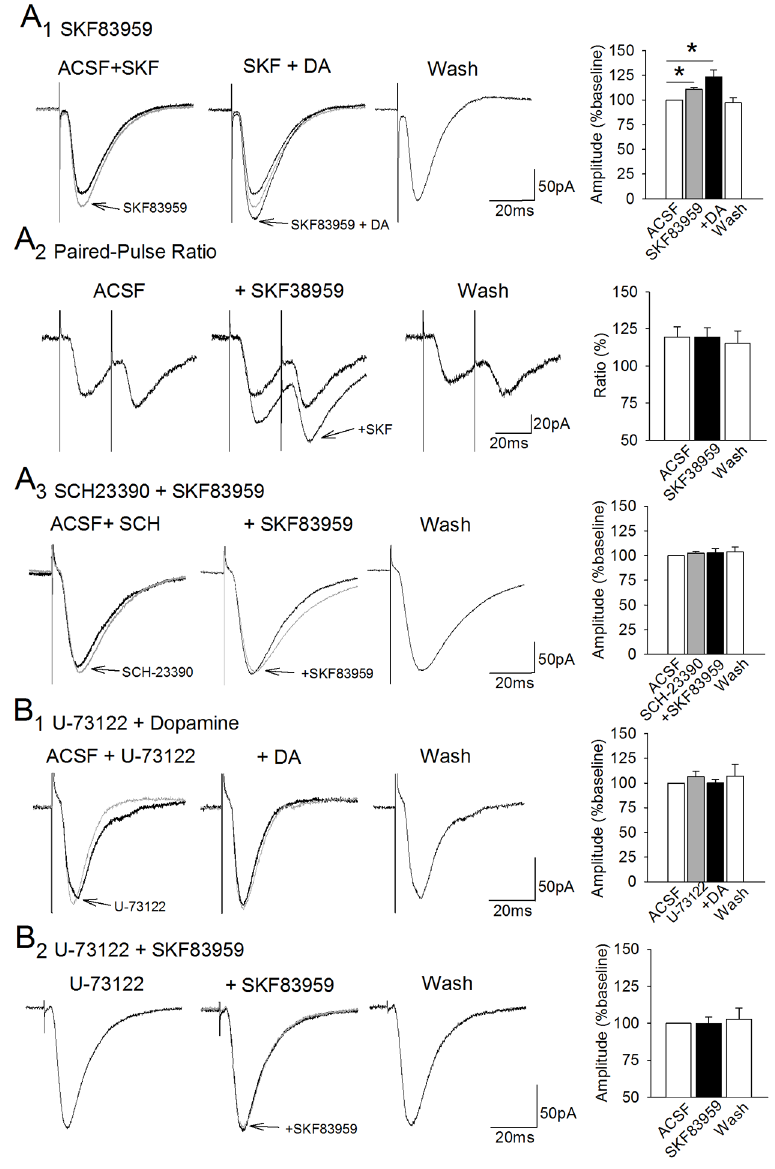
Fig 2. The facilitation of EPSCs induced by the D 1 agonist SKF83959 is dependent upon PLC activation. A. Bath application of the selective PI-linked D 1 -receptor agonist SKF83959 (5 or 10 μ M) resulted in a significant enhancement of EPSCs (A 1 , superimposed traces at left; * , p < 0.05). Subsequent addition of dopamine was followed by a further non-significant increase in mean EPSC amplitude (middle traces; p = .06). The facilitation of EPSC amplitude by SKF38959 was not associated with a change in paired-pulse facilitation ratio (A 2 ). Application of the D 1 receptor antagonist SCH23390 (10 μ M; A 3 ) blocked the facilitation induced by SKF83959. B. The PLC inhibitor U-73122 (10 μ M) had no effect on baseline EPSCs (B 1 , traces at left), but blocked the facilitation of EPSC amplitudes induced by dopamine (middle traces). Including U-73122 in the recording solution also blocked the facilitation of EPSC amplitudes induced by SKF83959 (B 2 ). Changes in synaptic responses were analyzed using Clampfit 8.2 software (Axon Instru- ments). For each cell, at least 10 consecutive synaptic responses free from artifacts or action potentials were averaged for each phase of recordings, and the amplitudes of averaged responses were measured relative to the pre-stimulus baseline. Raw data were analyzed using